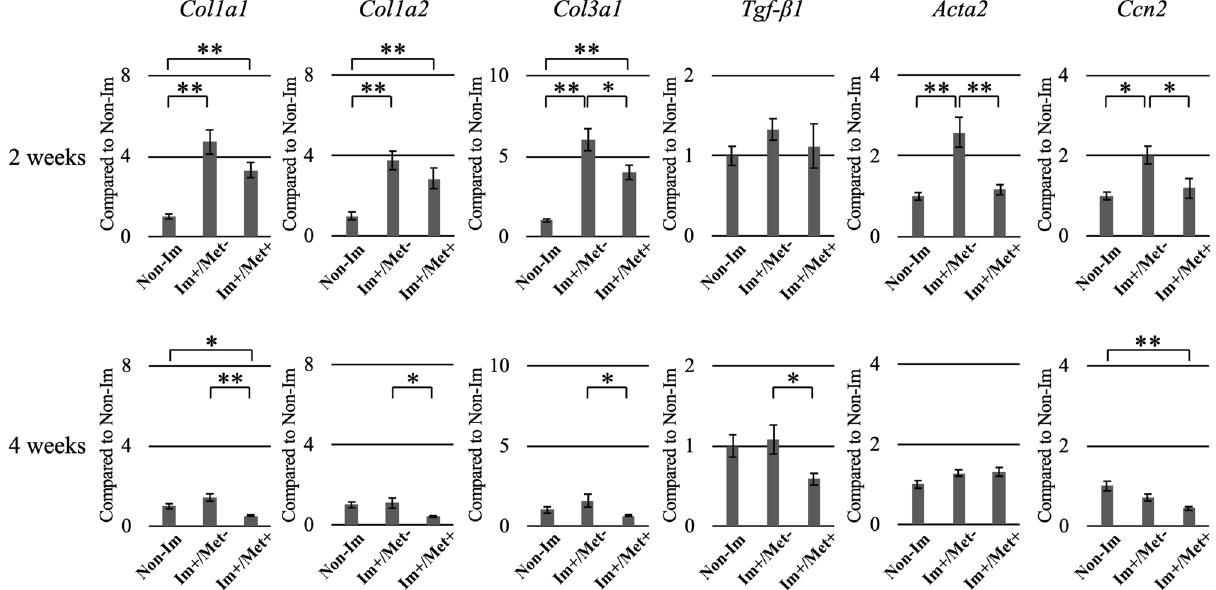
Figure 3. Expression analysis of the fibrosis-related genes in the knee joint capsule for the effect of metformin on joint capsular fibrosis. The mRNA expression of Col1a1 , Col1a2 , Col3a1 , Tgf-β1 , Acta2 , and Ccn2 was normalized to that of Gapdh . Data are expressed as the mean ± standard errors. *p < 0.05, **p < 0.01; n = 8. Col1a1 , collagen type IA1; Col1a2 , collagen type IA2; Col3a1 , collagen type IIIA1; Tgf-β1 , transforming growth factor beta 1; Acta2 , actin alpha 2; Ccn2 , cellular communication network factor 2; Gapdh , glyceraldehyde-3- phosphate dehydrogenase; Non-Im, mice with non-immobilized knees; Im+/Met−, mice with immobilized knees but no metformin; Im+/Met+, mice with immobilized knees who were administered